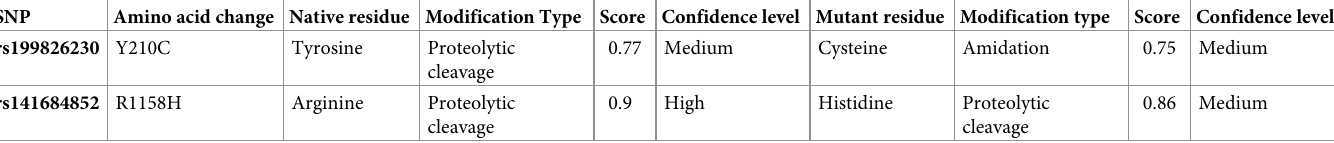
Table 5. Prediction of post-translational modification site of SNPs by